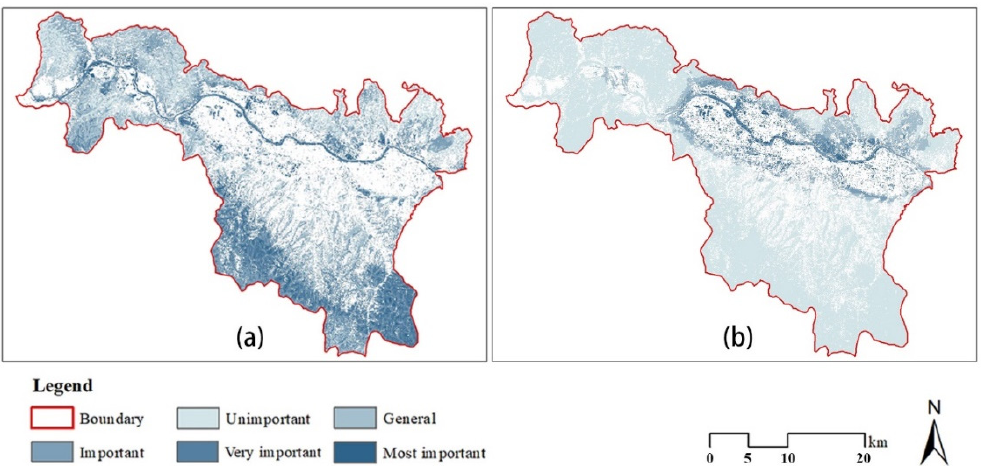
Figure 2. Maps of results of ( a ) ecological function evaluation and ( b ) ecological demand intensity evaluation in the study area.